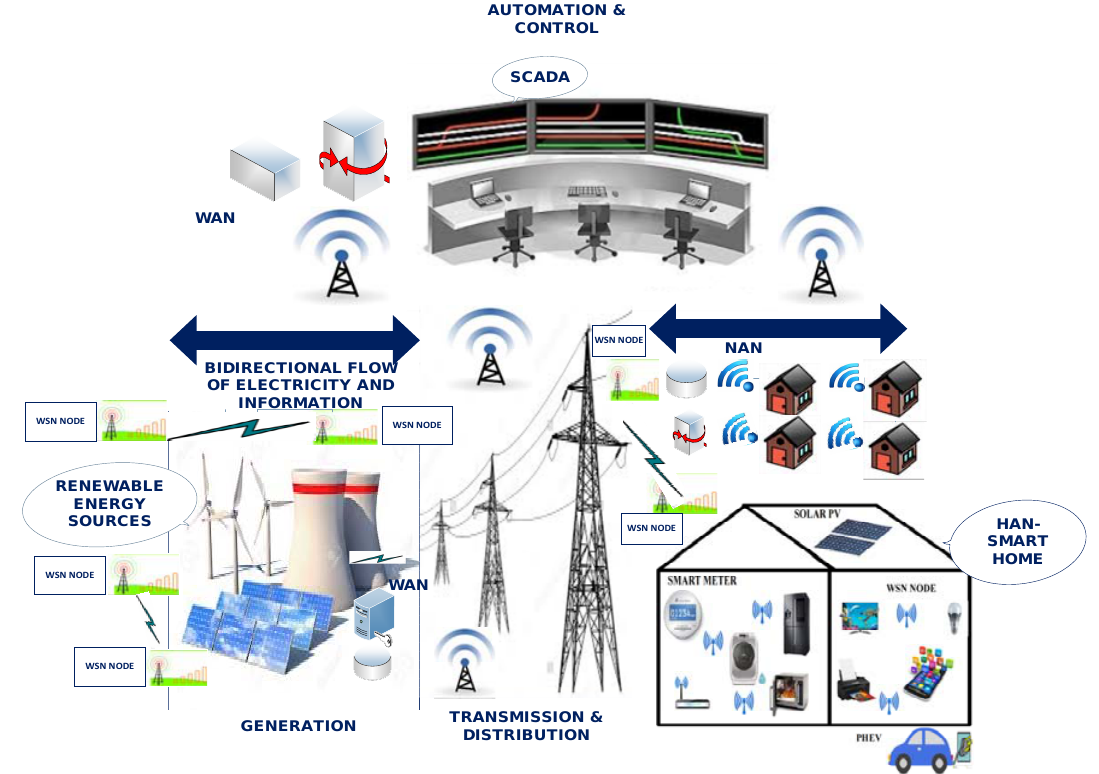
Figure 2. Application of WSN in smart grid hierarchical